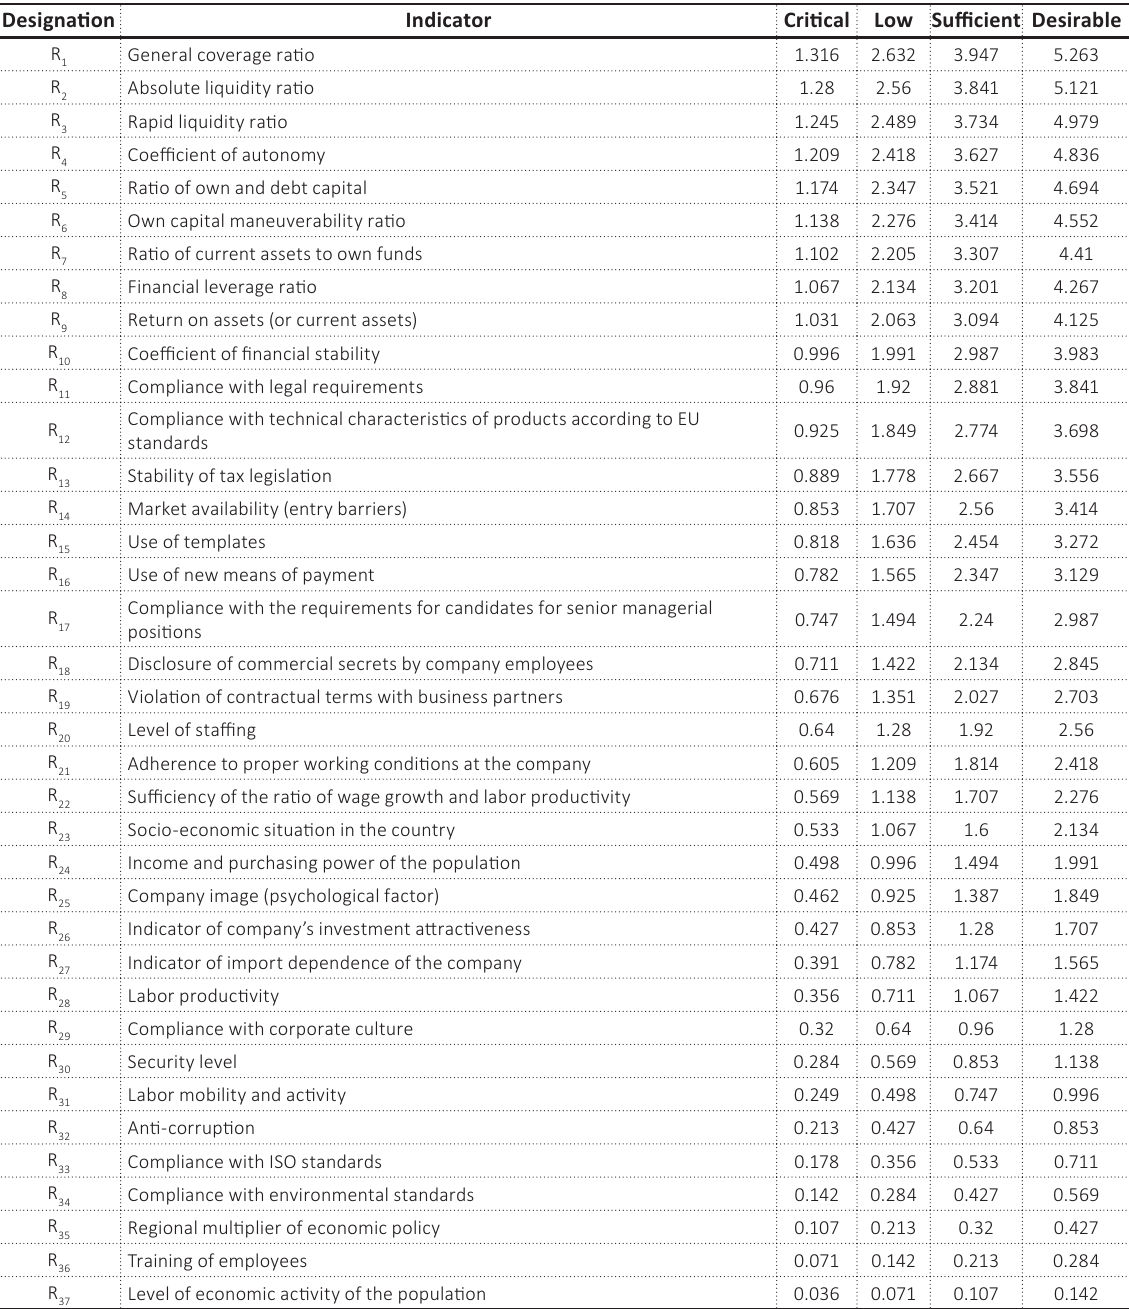
Table 5. Distribution of scores by levels (values)